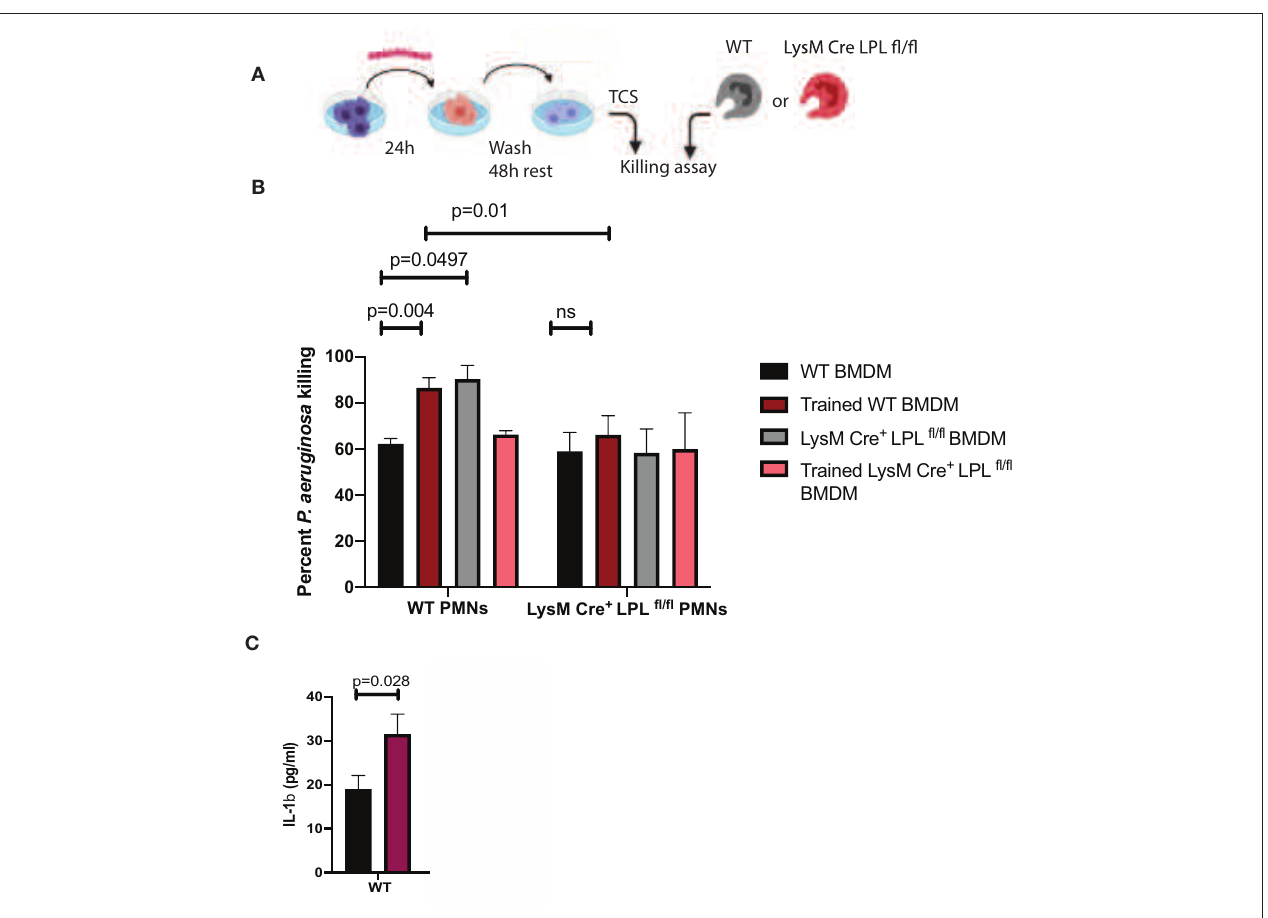
FIGURE 8 | LPL deficient neutrophils show compromised responses to priming signals, released by “trained” macrophages. (A) Schematic diagram depicting the experimental approach to generate “trained” macrophages. BMDMs were exposed to S. ovis (MOI = 1) for 24h, cells were washed, rested for 48h, then conditioned supernatants were harvested, and used to prime neutrophil killing. (B) Killing assays were carried out with WT PMNs (first set of bars) and LysMCre pos LPL fl . fl PMNs (second set of bars) in the presence of conditioned medium derived from “non-trained” WT BMDMs (black bars), “trained” WT BMDMs (red bars), “non-trained” LysMCre pos LPL fl . fl BMDMs (gray bars) and “trained” LysMCre pos LPL fl . fl BMDMs (pink bars) (Two-way ANOVA, p < 0.05). Data are representative of two experiments. Each bar shows mean values with SD based on four individual replicas per sample. (C) ELISA measurements of IL-1 β in the conditioned media from “non-trained” WT (black bars) and “trained” (purple bars) BMDMs. (Student’s t -test, p < 0.028). Representative data are shown out of two experiments. Cumulatively, data demonstrate that exposure to commensals “train” macrophages to prime neutrophil responses to P. aeruginosa . The LysMCre pos LPL fl . fl PMNs show bactericidal defects revealed upon exposure to priming